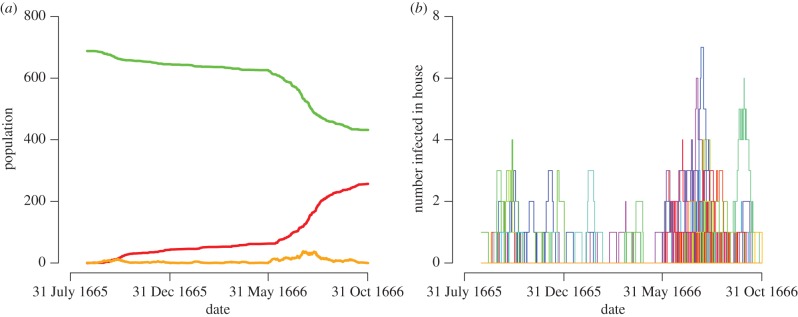
Eyam epidemic plot assuming an 11-day infection period. (a) Green line shows susceptible population; orange line shows infected population and red line shows number of deceased. (b) Each coloured line represents the number of infected people in a household. (Online version in colour.)